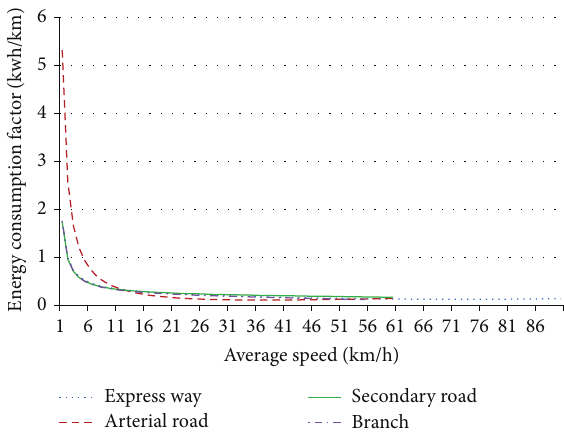
Figure 6: Energy consumption factors for different road